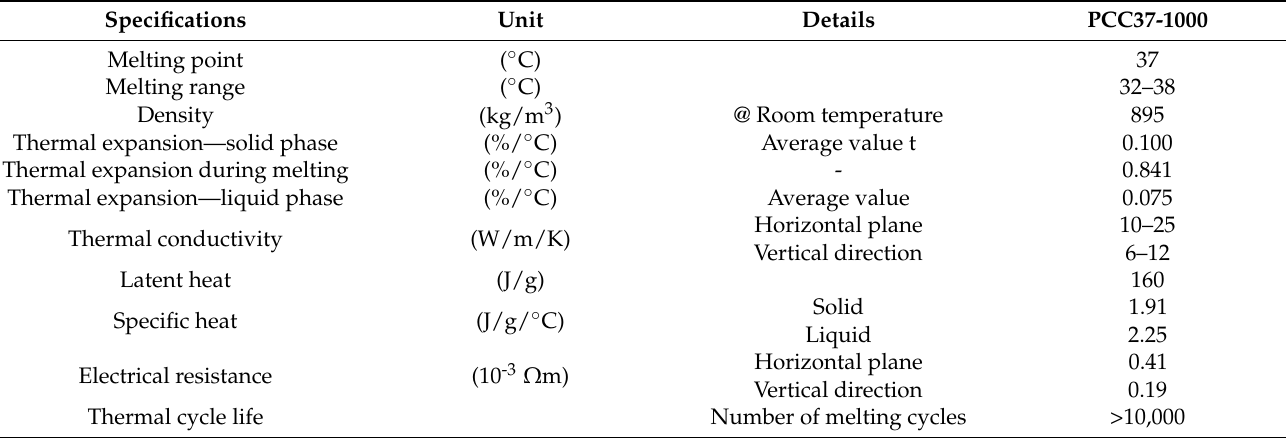
Figure 3. ( a ) Different shapes of the PCM EG matrix, and ( b ) overall pack assembly (with the courtesy of AllCell Technologies). Table 2. Properties of the PCM-graphite matrix [16].